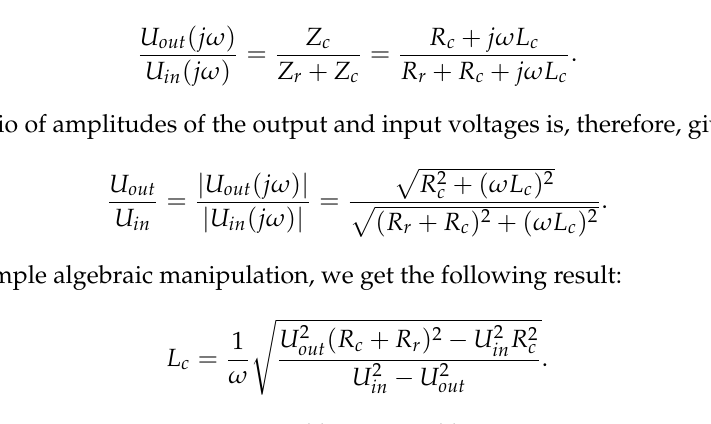
Figure 5. Input voltage U in and output voltage U out in a scheme to determine the coil’s inductance L c . The ratio between output voltage U out ( t ) and input voltage U in ( t ) can be obtained by a simple voltage divider rule,